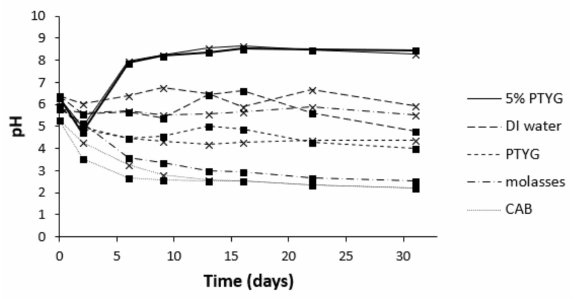
Figure 1. Changes in pH in five microbiological media over 31 days. Aspergillus ( squares ) and Bacillus ( crosses ).